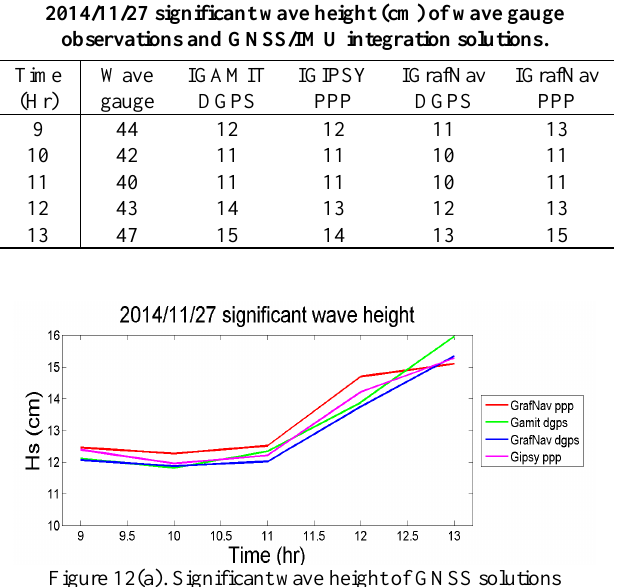
Figure 12(a). Significant wave height of GNSS solutions